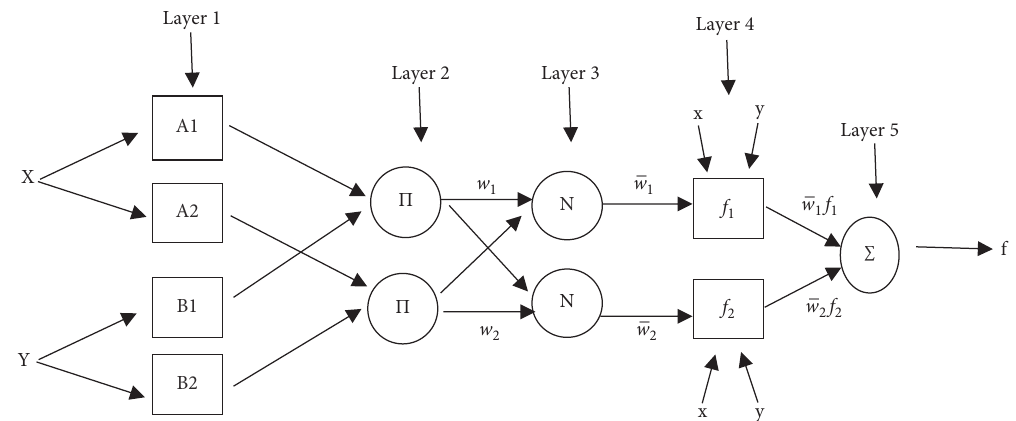
Figure 1: A simple example of the structure with two input